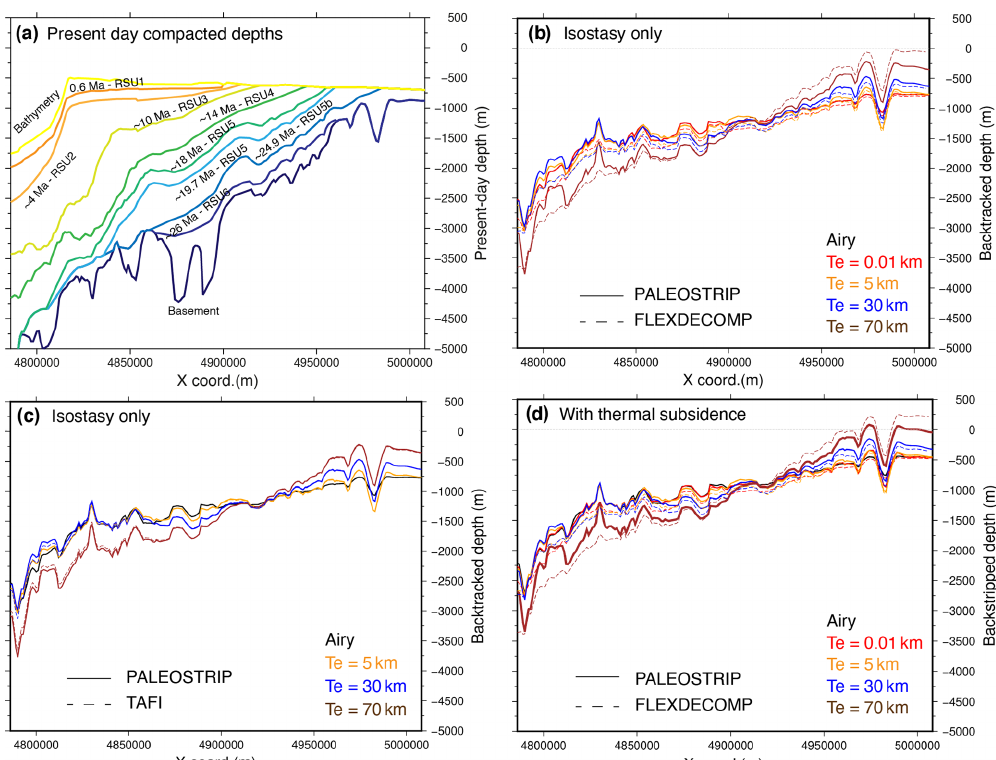
Figure 6. The 2D transect BGR80-007 case study. (a) Input present-day compacted depths ( m ) of bathymetry (yellow) and the nine seismic unconformities, including the mid-Miocene Ross Sea Unconformity 4 (RSU4) and basement (thick blue line). Layout is from the PALE- OSTRIP Plot GUI. Comparison of backtracked basement depths for different but spatially uniform lithospheric elastic thicknesses (Te): (b) between the PALEOSTRIP finite difference isostasy and the Flex-Decomp (Kusznir et al., 1995) fast Fourier transform (wavenumber- based) isostasy model; (c) between PALEOSTRIP finite difference isostasy and the TAFI (Jha et al., 2017) Green’s function spectral isostasy model. Panel (d) is the same as (b) but accounts for the thermal subsidence correction using a rift age of 85Myr and a uniform β of